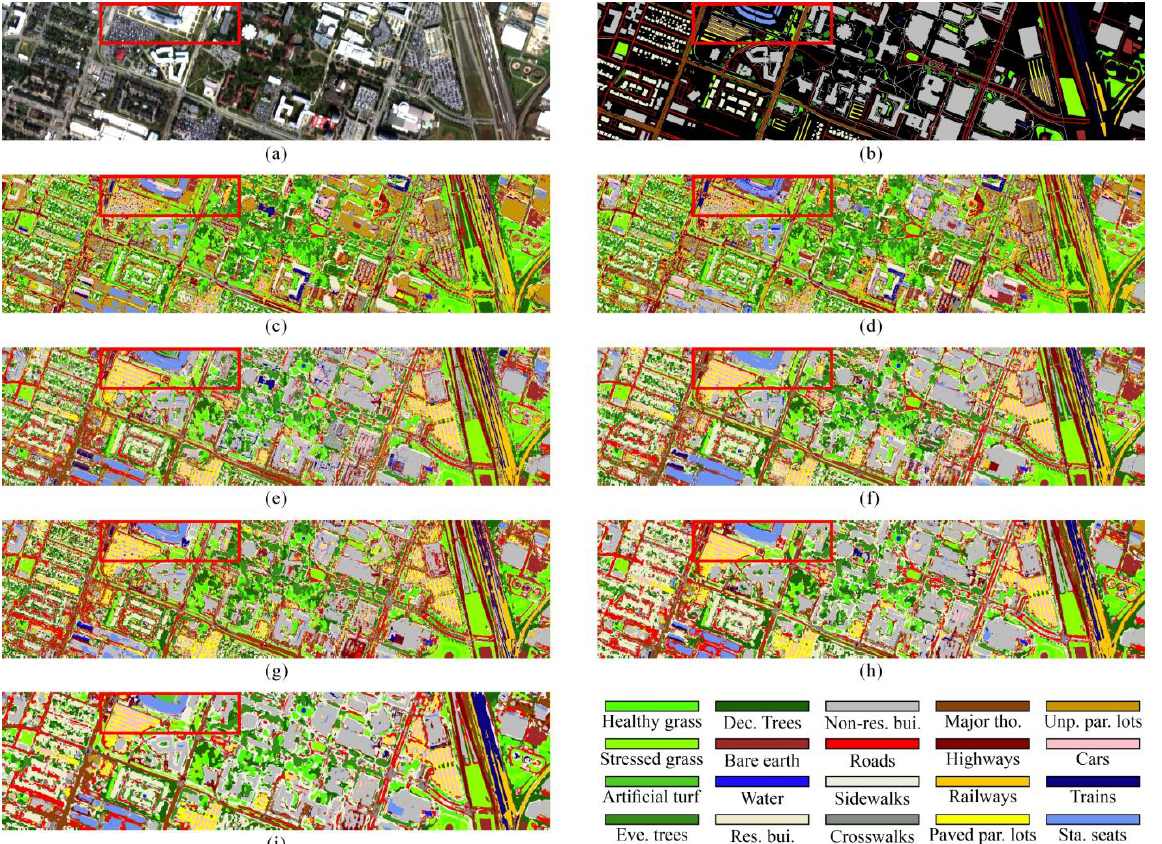
Figure 8. The classification results obtained using different methods on the Houston 2018 dataset. ( a ) Three-band composite image of the Houston 2018 HSI. ( b ) The ground truth of Houston 2018 HSI. The classification results of ( c ) SVM, ( d ) 1D CNN, ( e ) R2D, ( f ) 2D CNN, ( g ) 3D CNN, ( h ) MCM, and ( i ) LGSF.